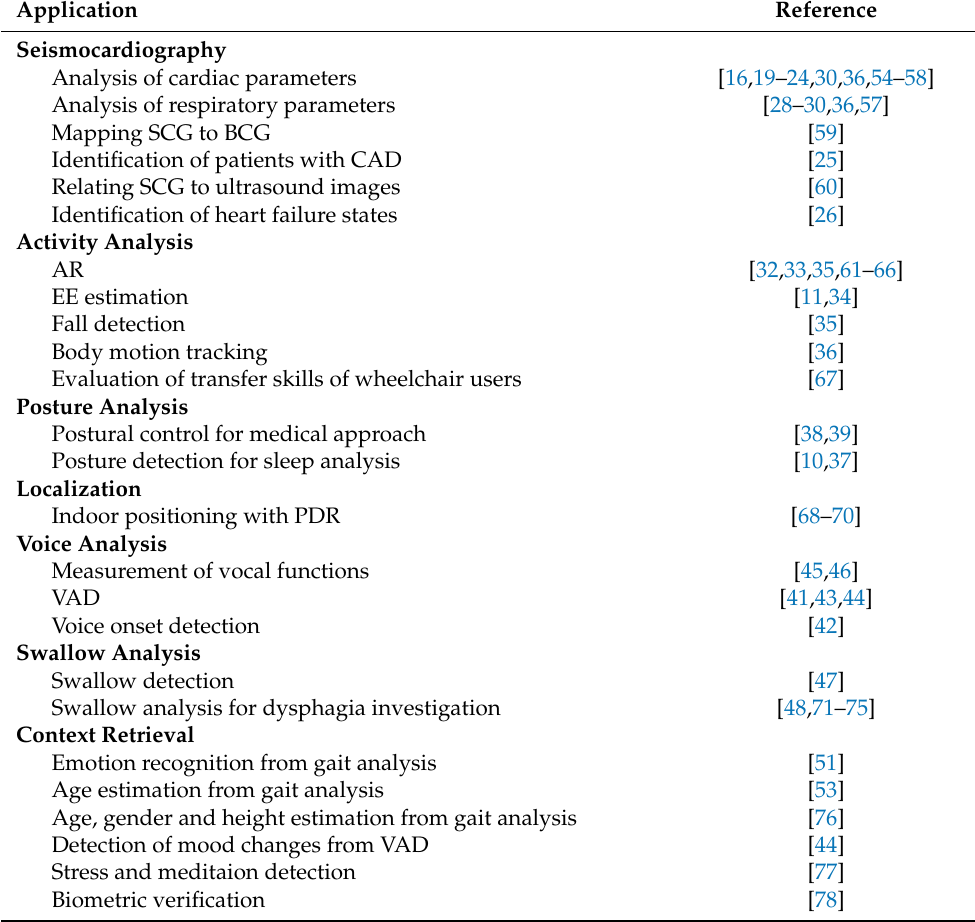
Table 2. Applications of the chest-worn inertial sensors categorized according to the referenced